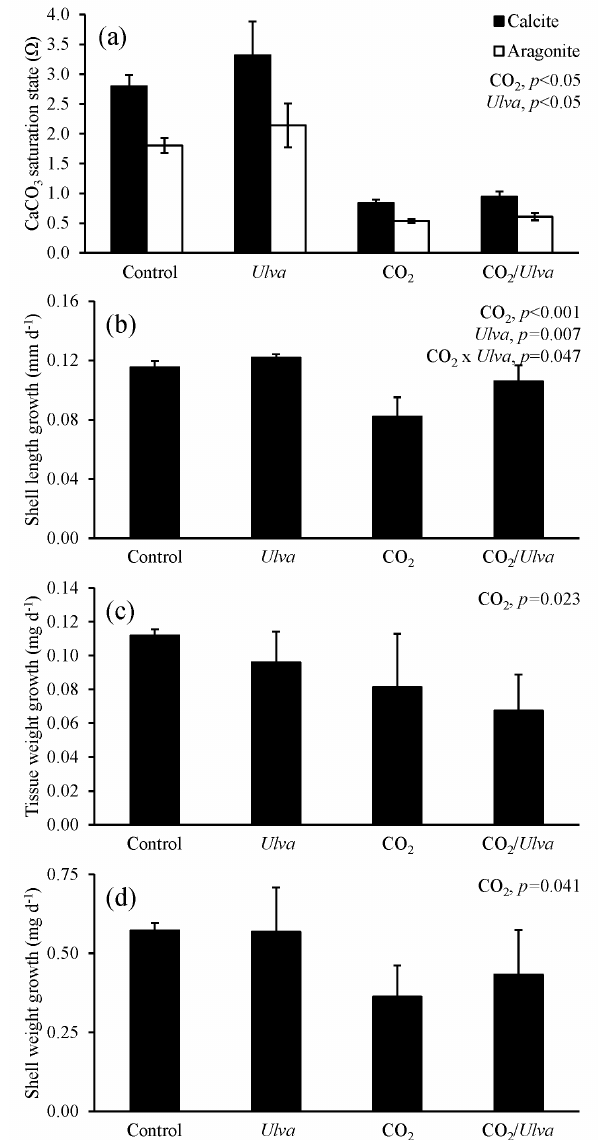
Figure 5. Experiment with small juvenile Argopecten irradians ex- posed to ambient and elevated concentrations of CO 2 with and without the presence of Ulva . (a) (cid:127) calcite and (cid:127) aragonite ; growth was based on (b) shell length, (c) tissue weight, and (d) shell weight. Columns represent means ± standard deviation. Significant main treatment effects (CO 2 and Ulva ) appear at the top right of each panel.